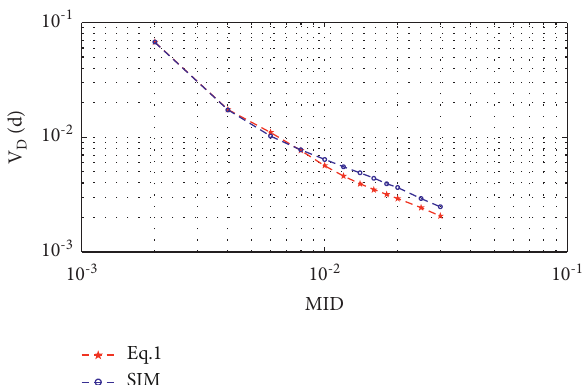
Figure 16: 4-story building seismic demand hazard curve results comparison using Equation (1) and ANN model.